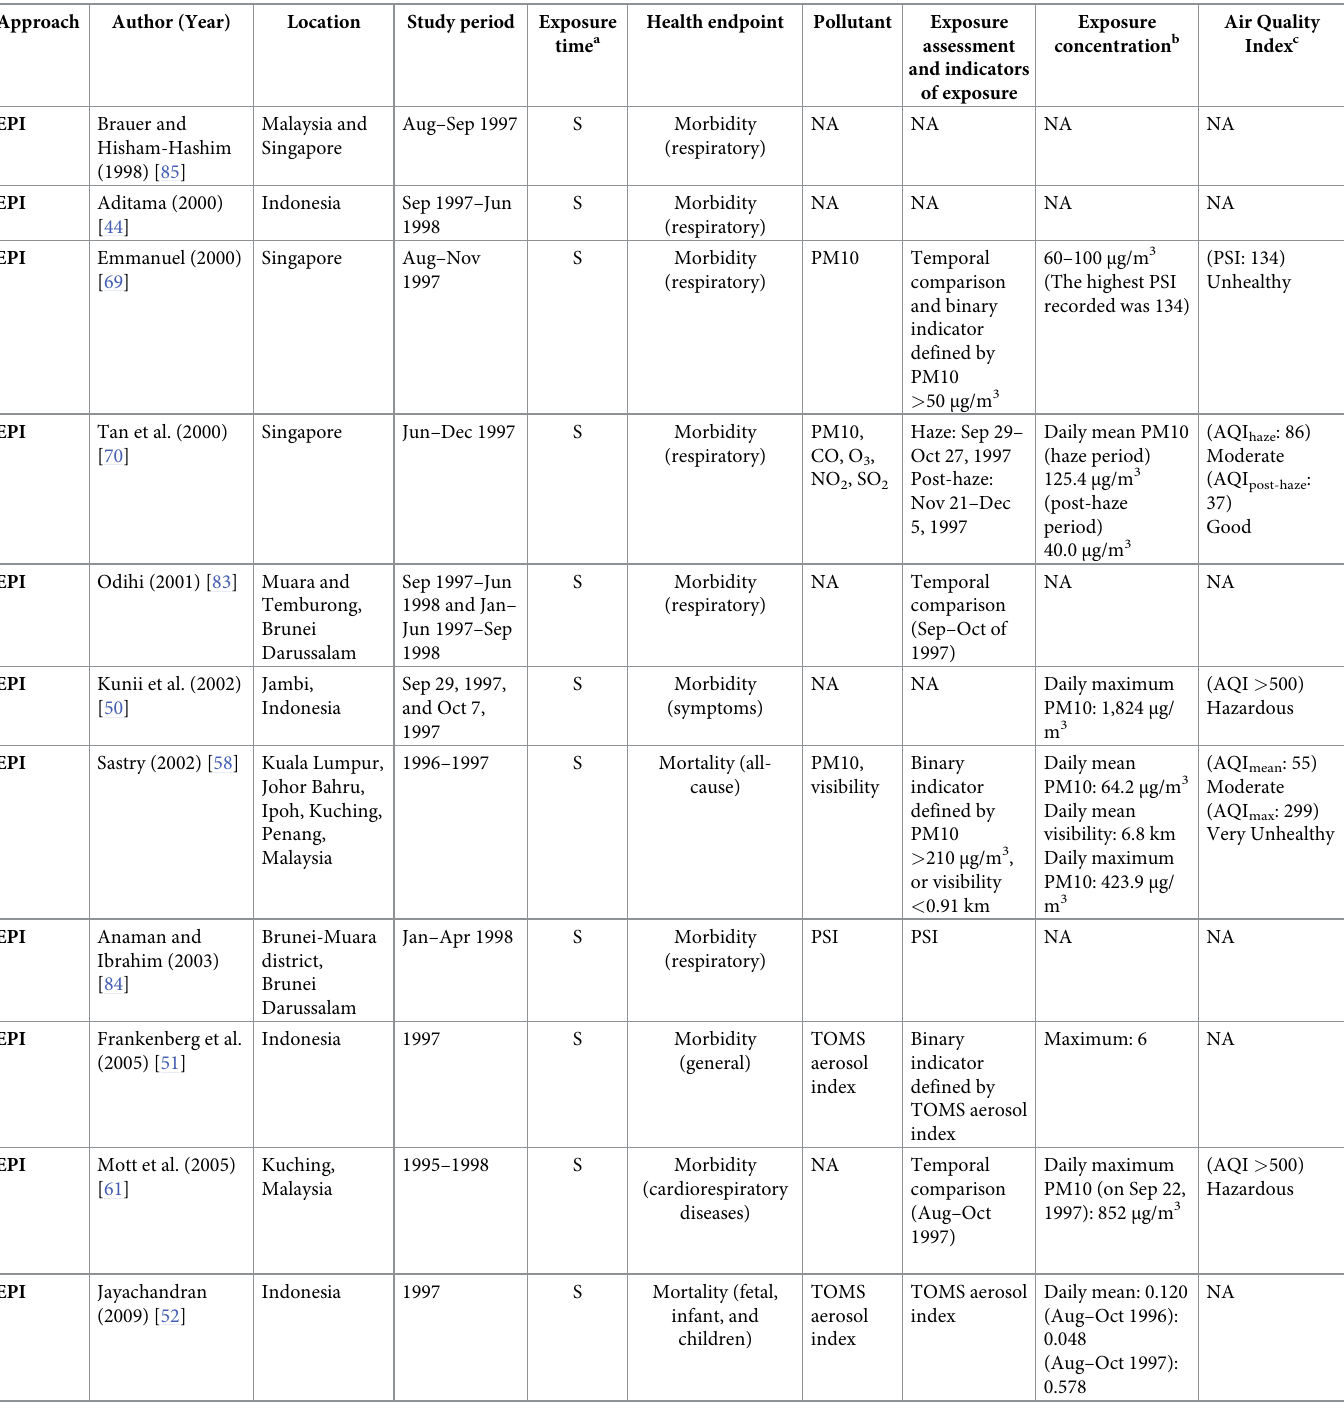
Table 2. Summary of studies on the health effects of smoke haze in Southeast